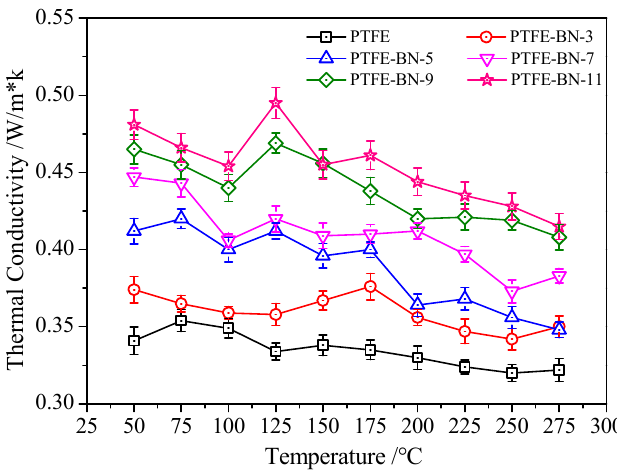
Figure 3 . Thermal conductivity of specimens from 50 to 275 °C.